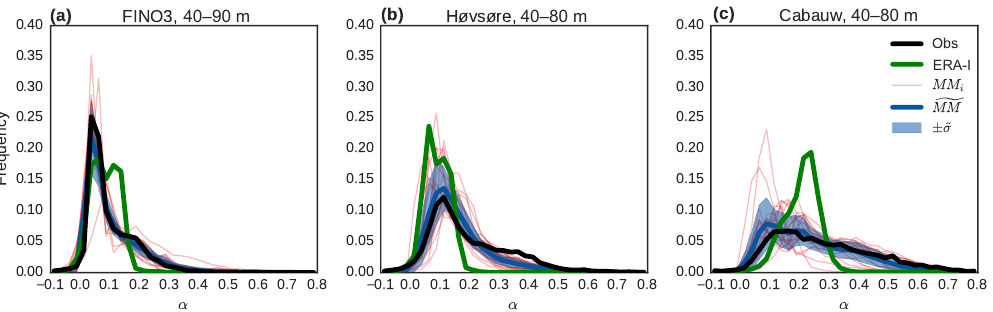
Figure 10. Frequency of occurrence of the shear exponent ( α ) at the three sites for the observations (black), the ERA-Interim data set (green), the mesoscale models MM i (red), and the inter-model mean (blue line) and standard deviation g MM ± e σ (blue shade).